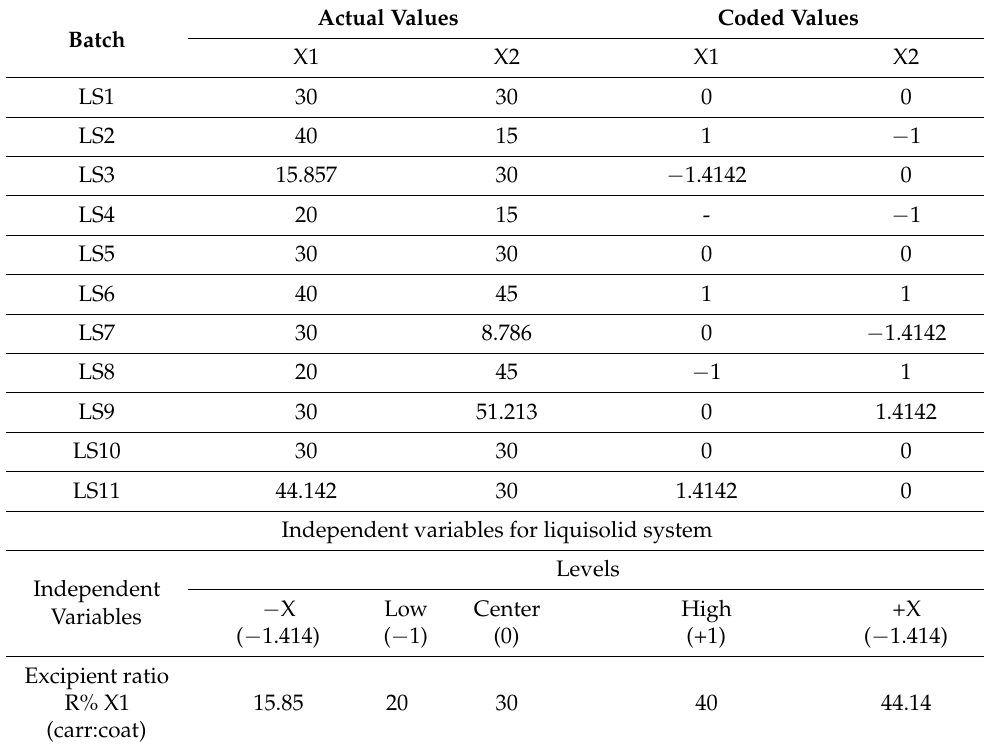
Table 1. Levels of independent variables of central composite experimental